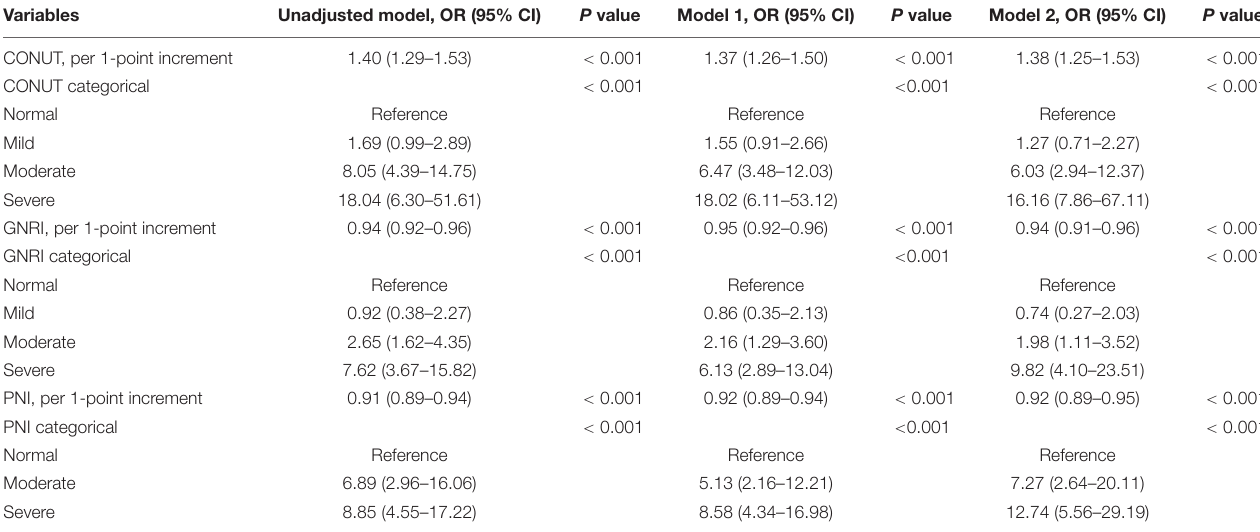
TABLE 2 | Logistic regression analyses of the three malnutrition indexes to predict mortality at 3 months after intravenous